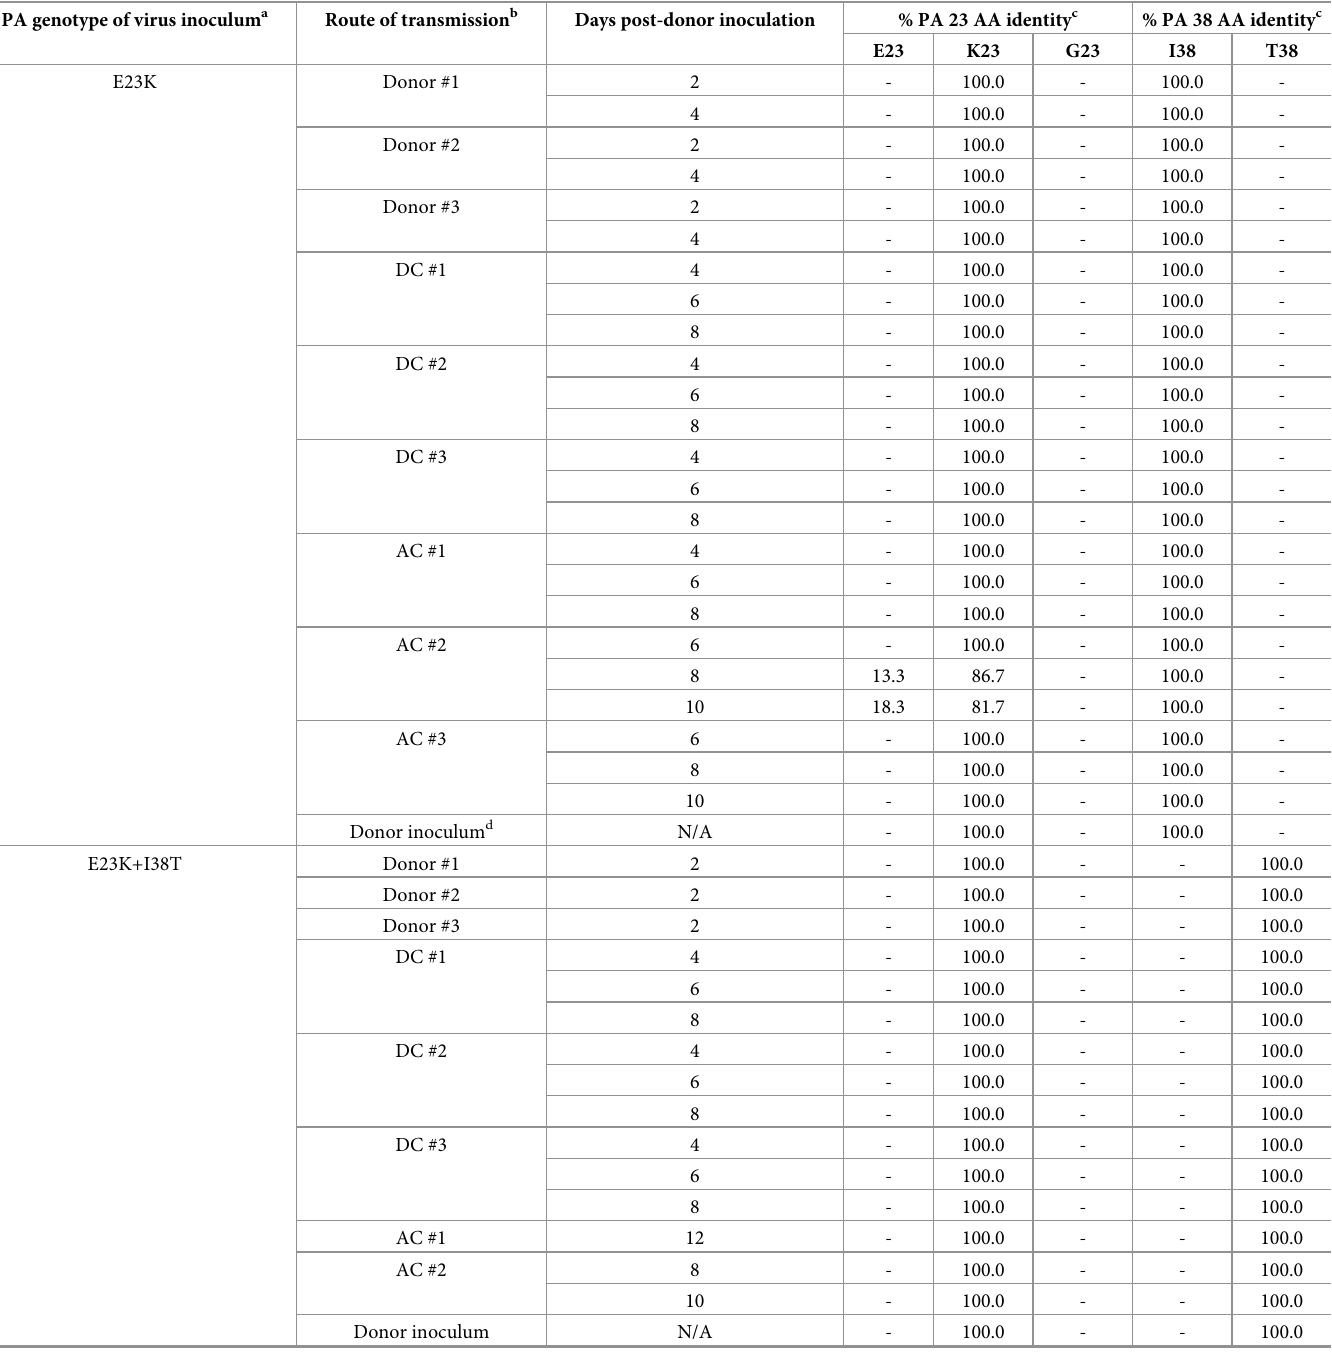
Table 3. Genotype of A(H1N1)pdm09 viruses isolated from ferret nasal washes. PA genotype of virus inoculum